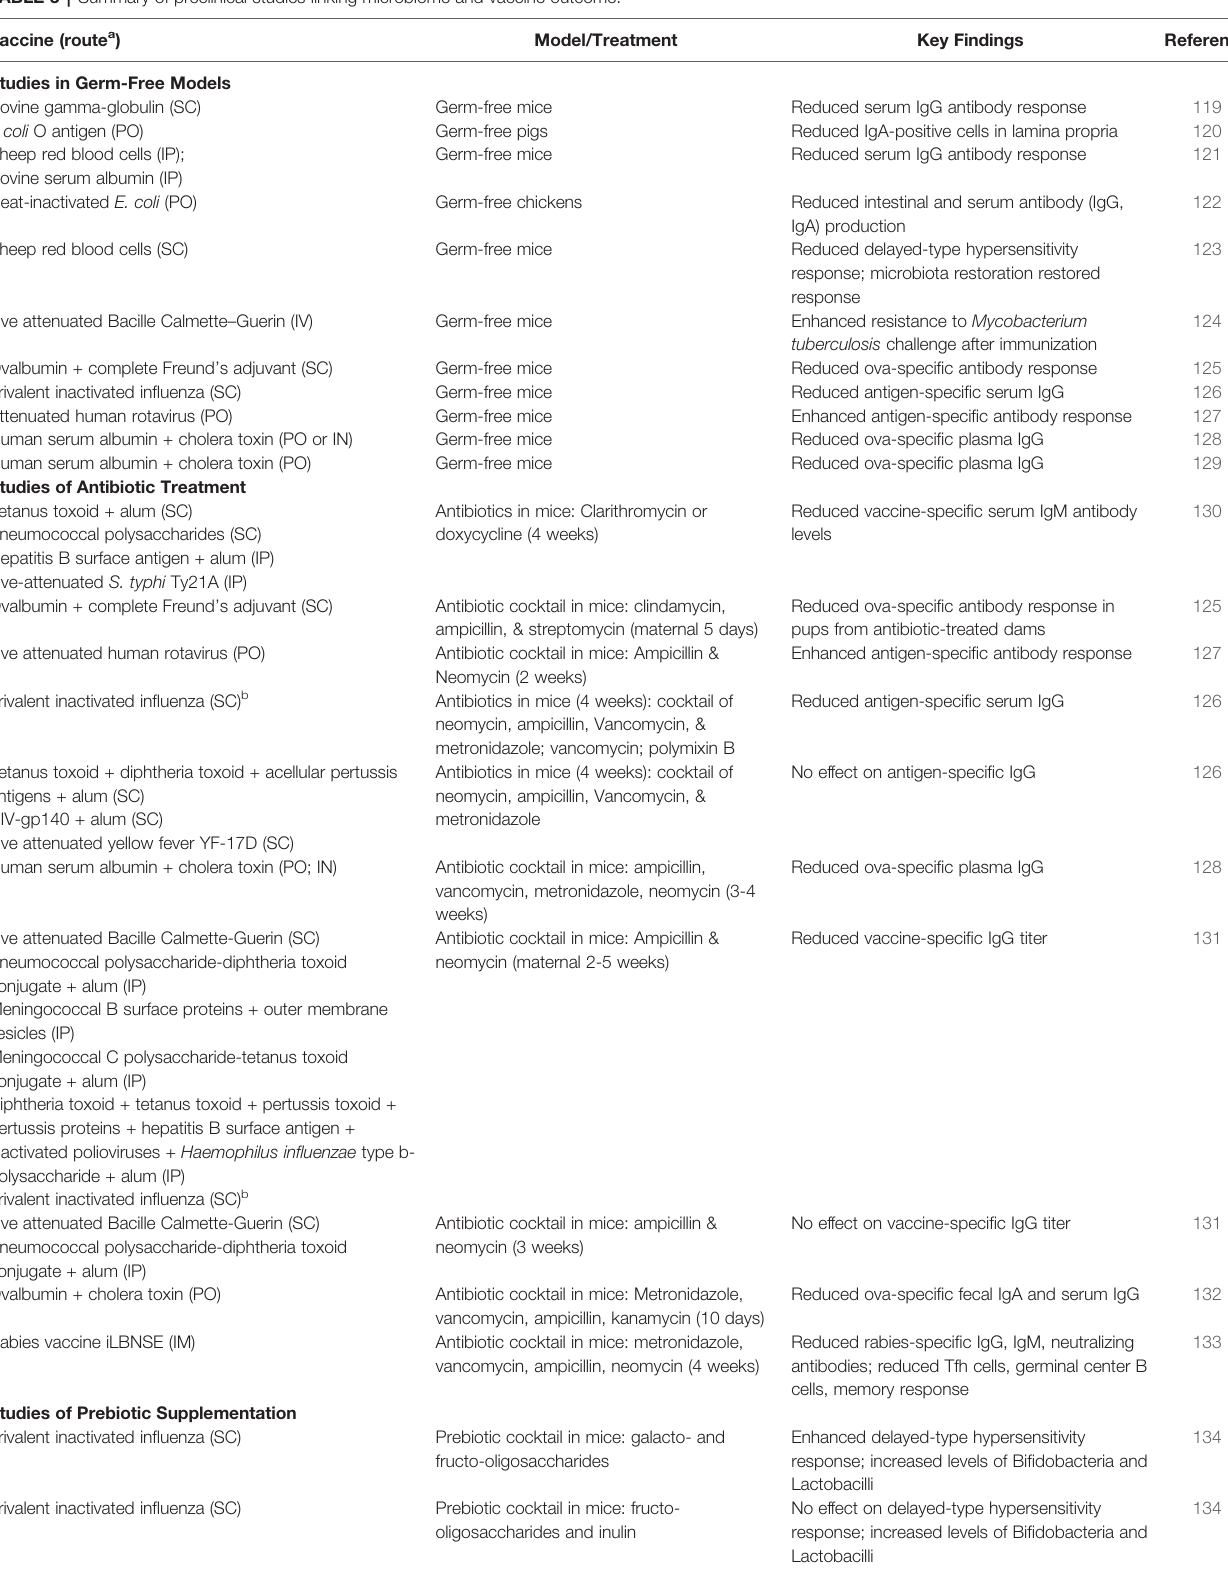
TABLE 3 | Summary of preclinical studies linking microbiome and vaccine